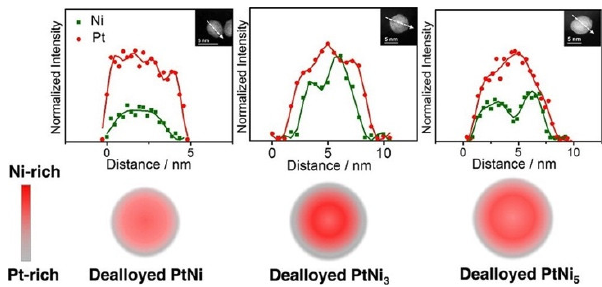
Figure 6. Composition distributions of dealloyed NiPt nanoparticles (NPs) with different initial atomic ratios and their corresponding electron energy loss spectroscopy (EELS) line profiles. Reprinted with permission from reference [73]. Copyright 2014 American Chemical Society.